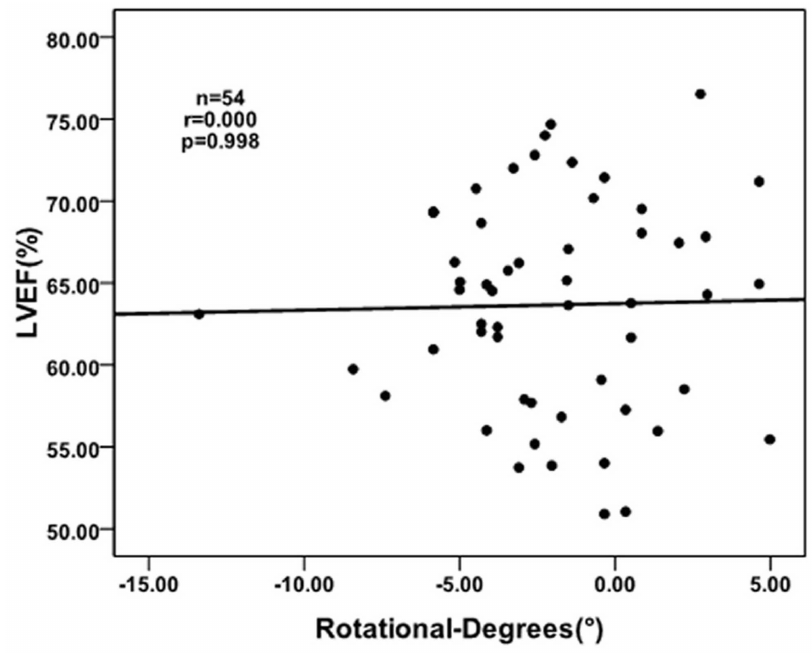
Figure 5. At the peak LV torsion, the correlation between the rotational degrees at the papillary muscle short-axis plane and the LVEF in the normal subjects (r=0.000, p=0.998).